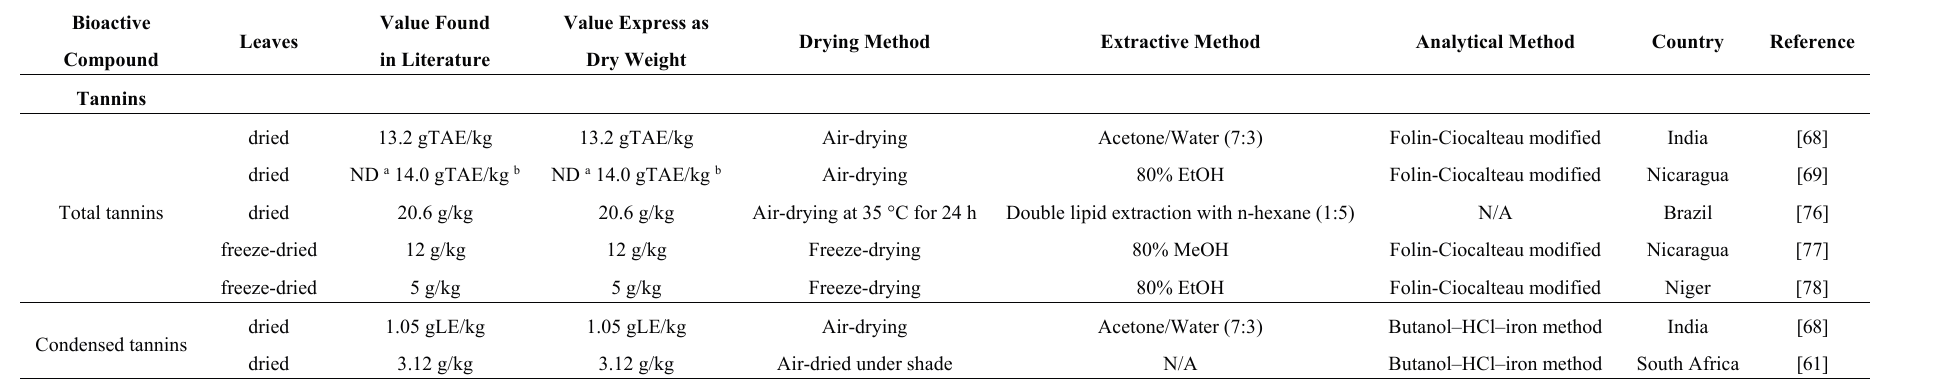
Table 7. Tannins content in Moringa oleifera leaves.